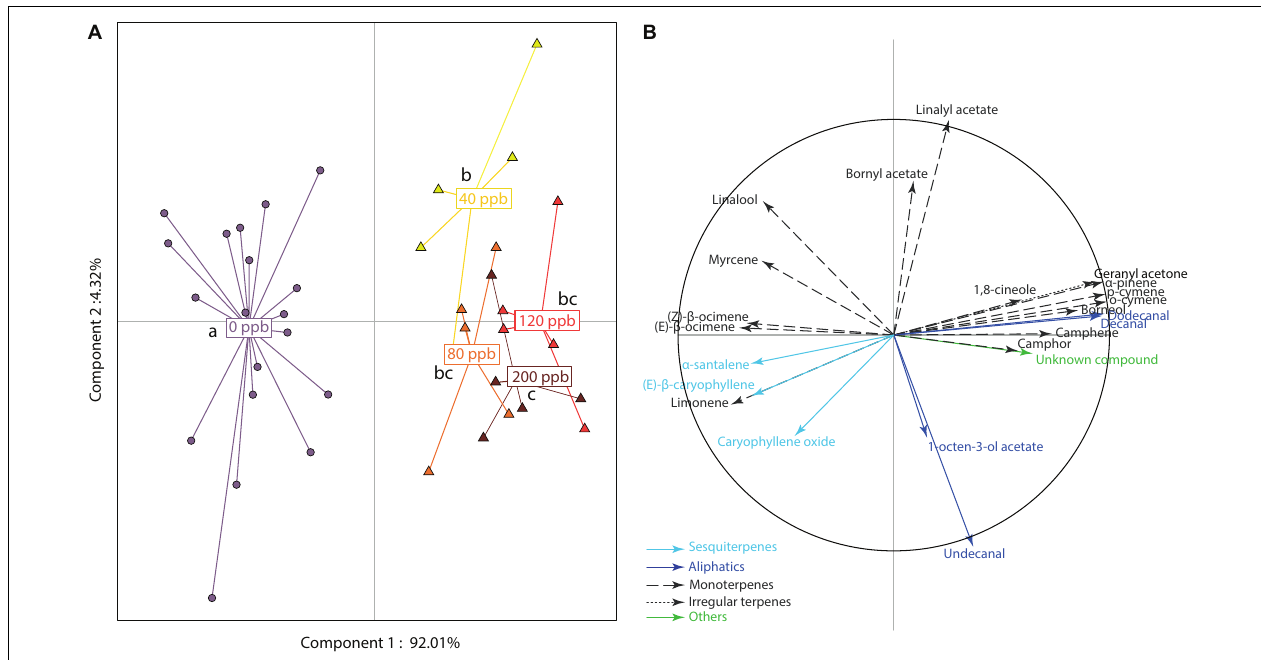
FIGURE 7 | Partial Redundancy Analysis (pRDA) score plot from the constrained Principal Component Analysis of the relative proportions of flowering lavender volatile organic compounds (VOCs) sampled in the reactor as a function of the [O 3 ] during experiment 2 (A) and the associated correlation circle (B) . Purple, yellow, orange, red, and brown colors correspond, respectively, to an exposure of 0, 40, 80, 120, and 200 ppb O 3 and symbols indicate whether the VOCs in the reactor were exposed to 0 ppb O 3 (circles) or increasing [O 3 ] (triangles). Groups with different letters next to the barycenters show statistically significant differences based on the permutation test assessing the pairwise comparisons at the threshold of